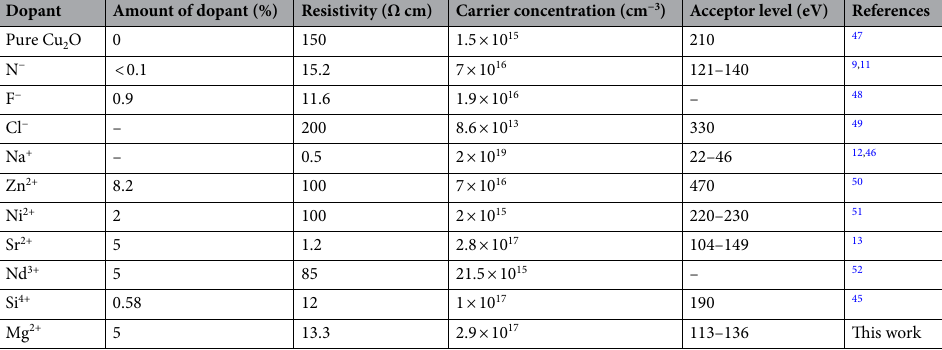
Table 2. Electrical properties of dopants used in Cu 2 O thin films: resistivity, carrier concentration at room temperature and acceptor level